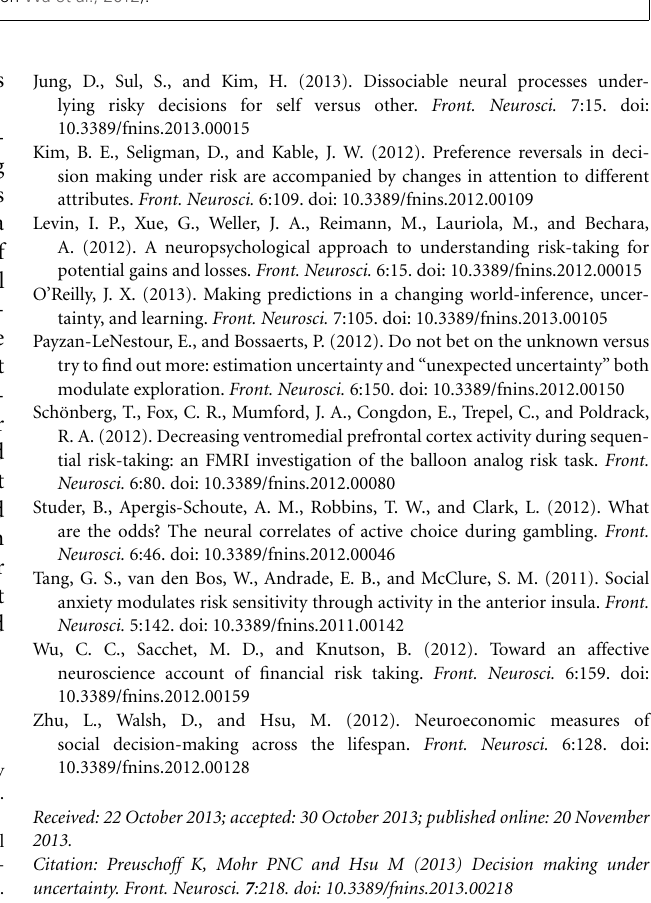
FIGURE 1 | Activation Likelihood Estimate (ALE) meta-analytic maps for high versus low mean, variance, and skewness. ALE of mean: bilateral NAcc. ALE of variance: bilateral anterior insula. ALE of skewness: left NAcc. (based on Wu et al., 2012).